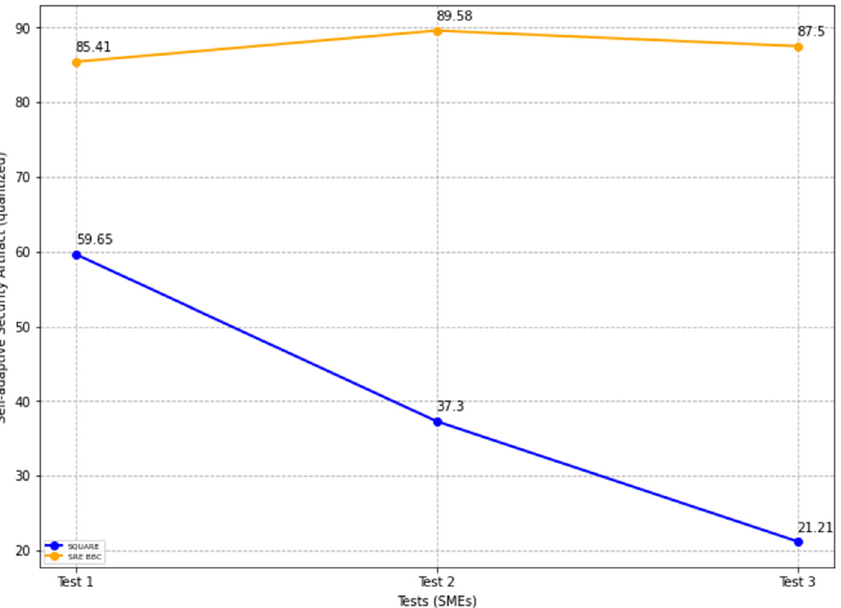
Figure 15. The comparison of quantified self-adaptive security evaluation quality for SQUARE and SRE_BBC (Feasibility Study).